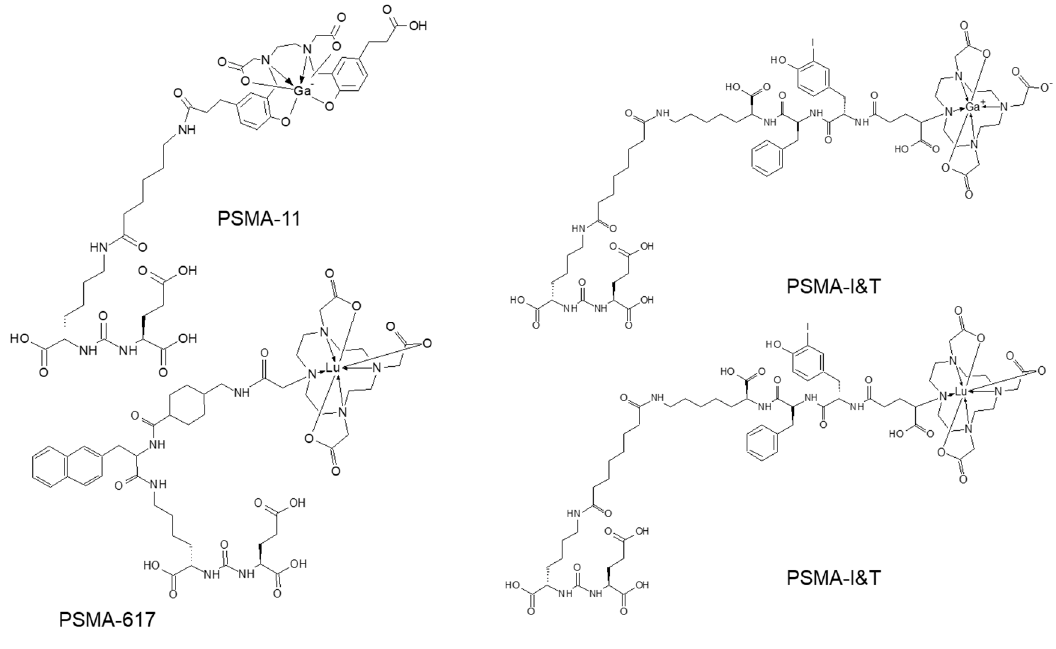
Figure 7. Molecular structures of prostate specific membrane antigen (PSMA) analogues based on Glu–urea–Lys motif.